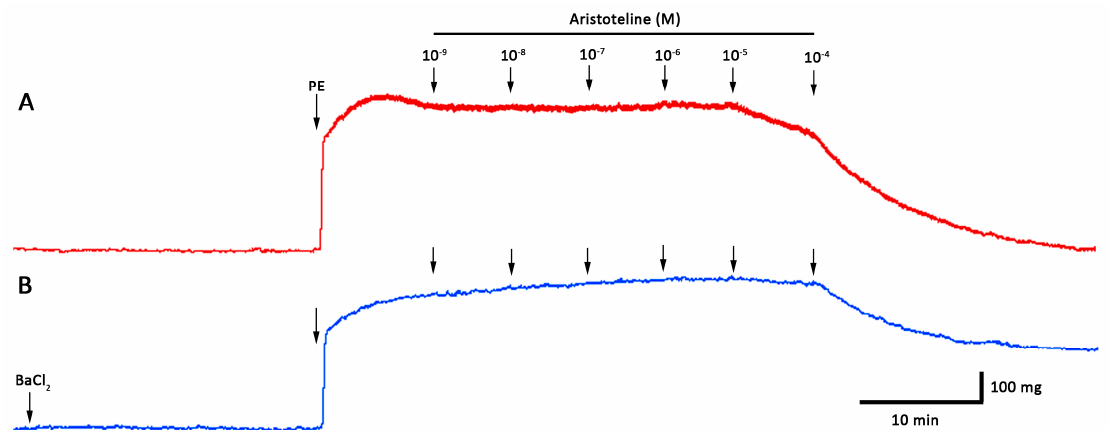
Figure 6. Original trace showing the time course of the concentration–response curves to ARI in intact aortic ring from rat in absence ( A ) and presence of BaCl 2 (10 μ M; B ). The aortic ring was pre-incubated with BaCl 2 for 20 min before PE (1 μ M) was added.